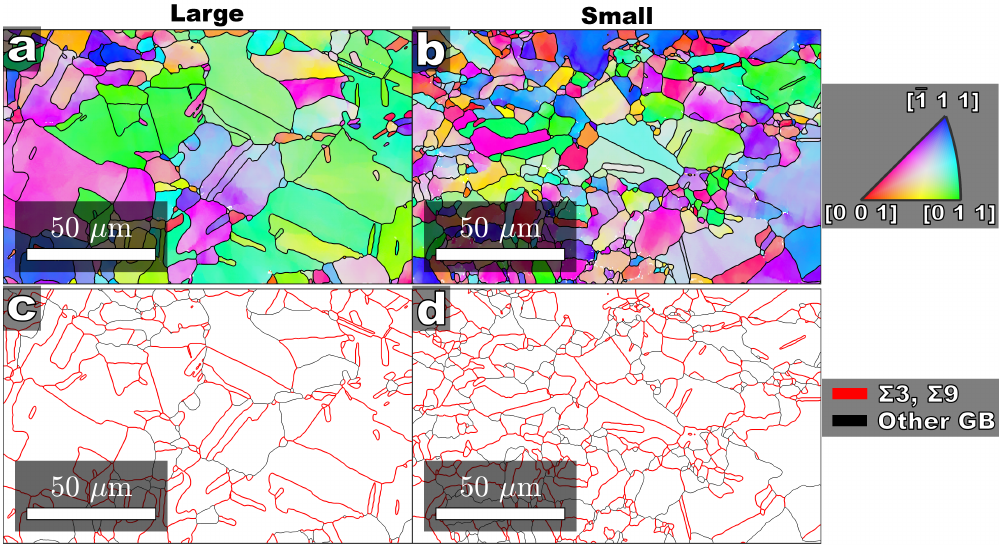
Figure 5. Microstructural evaluation of the deposit edge by EBSD. The two columns of microstructural maps correspond to edge deposit region of large grains ( left ) and edge deposit region of small grains ( right ). The rows correspond to inverse pole figure maps ( a , b ) and twin boundary maps ( c , d ). The color scheme for each row is located to the